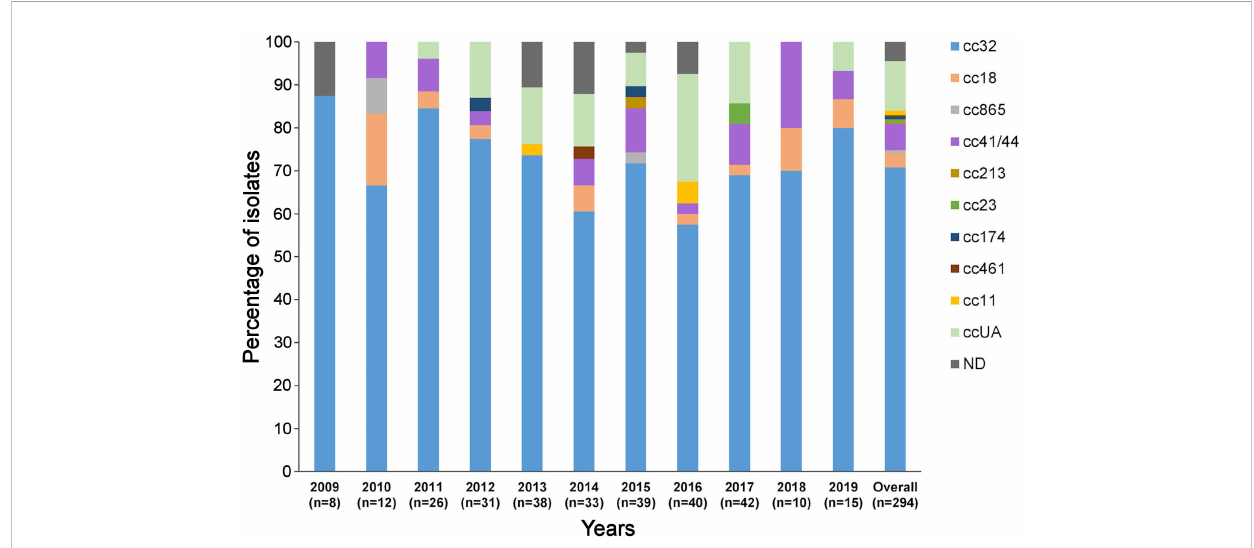
FIGURE 1 Distribution of clonal complexes in the panel of 294 isolates by year. ccUA, sequence type not assigned to any cc; ND, MLST pro fi le not available; cc, clonal complex; n, number of